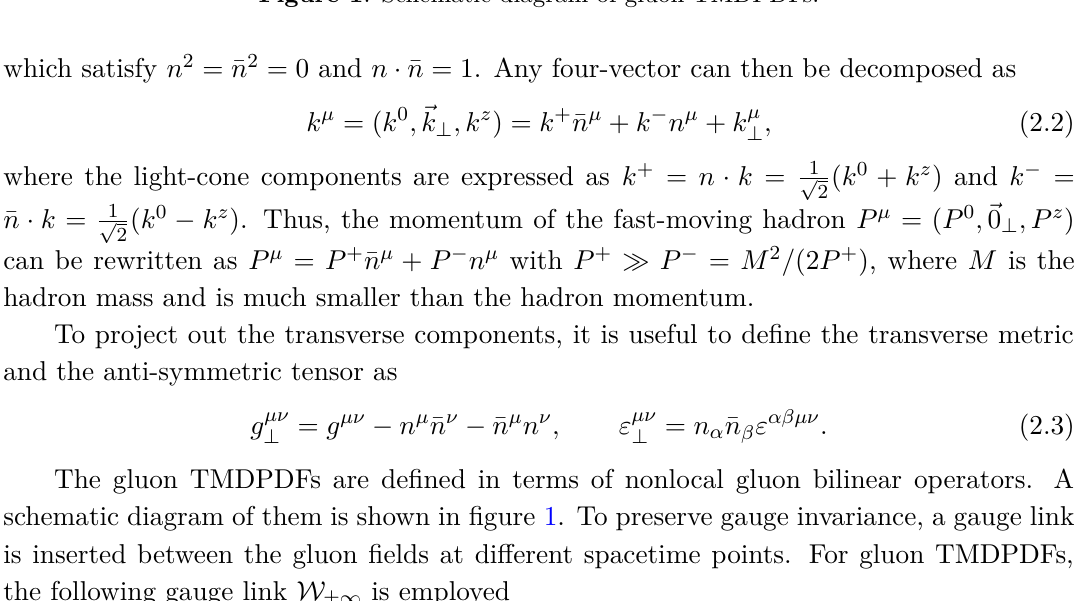
Figure 1 . Schematic diagram of gluon